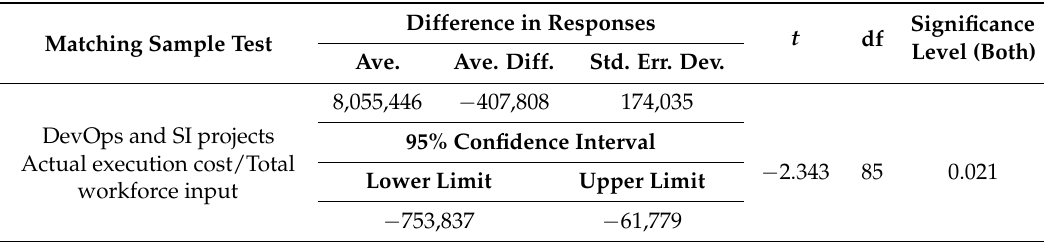
Table 14. Matching sample